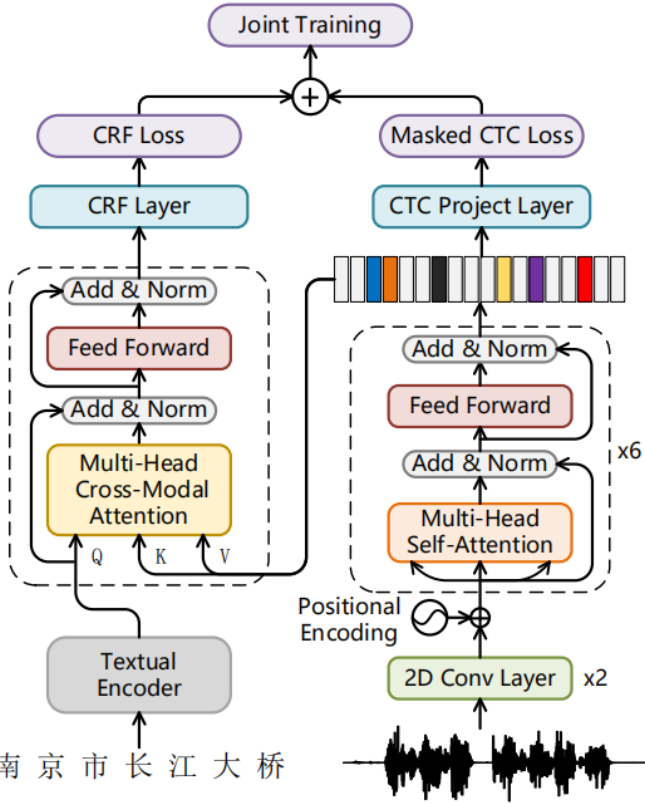
Figure 11. M3T was proposed to capture the natural monotonic alignment between text and acoustic modes [100].